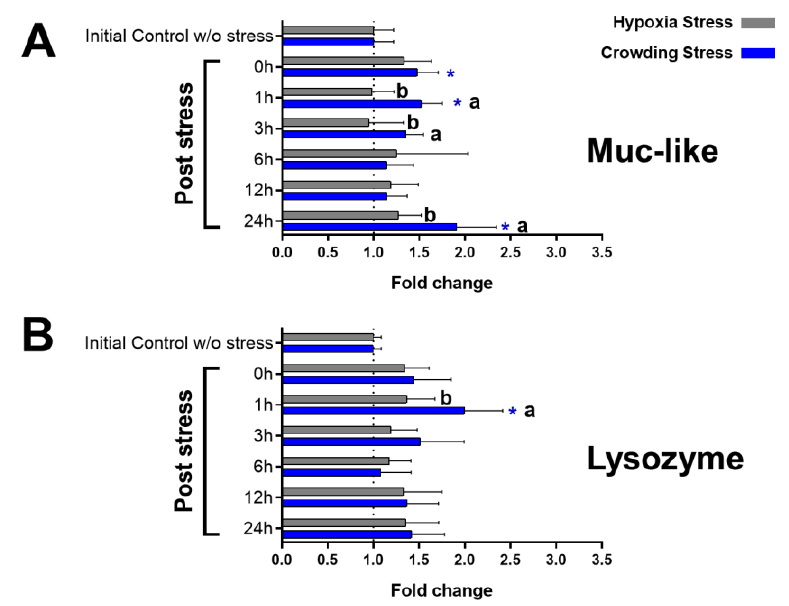
Figure 3 . Immunological markers in skin mucus by indirect ELISA (as fold of change relative to the initial control ± standard deviation). ( A ) Muc-like protein . ( B ) Lysozyme. Sampling groups: initial control group (without stress) and 0, 1, 3, 6, 12, and 24 h post-stress. In grey, hypoxia stress; in blue, crowding stress. Significant differences ( p < 0.05) are denoted with * (compared with initial control group) and with the letters (a and b (compared between stress models).